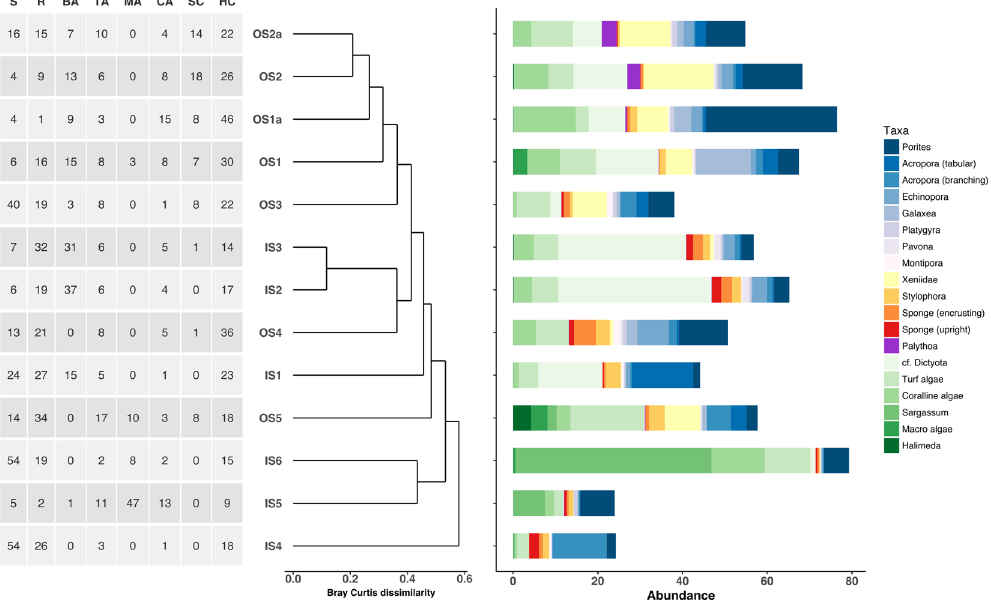
Figure 2. Cluster diagram of sites based on benthic composition of Bray-Curtis dissimilarity and associated benthic species by site indicating cross shelf gradient from Outer Shelf (OS) to Inner Shelf (IS). Note colors groupings on histogram where Blue = Corals, Red and Orange = Sponges, Green = Algae. S = Sand, R = Rubble, MA = Macroalgae, SC = Soft Coral, HC = Hard Coral, CA = Coralline Algae, BA = Brown Algae, TF = Turf Algae.